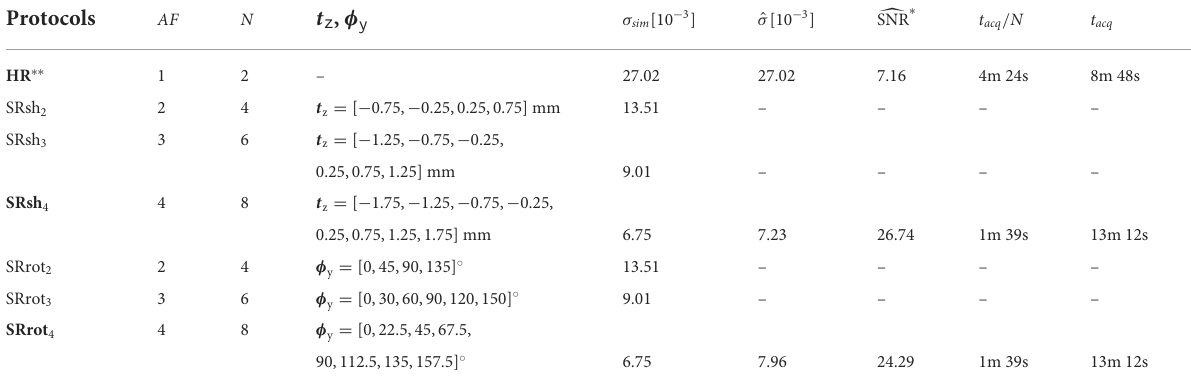
TABLE 1 MS-SRR acquisition protocols included in the comparison.